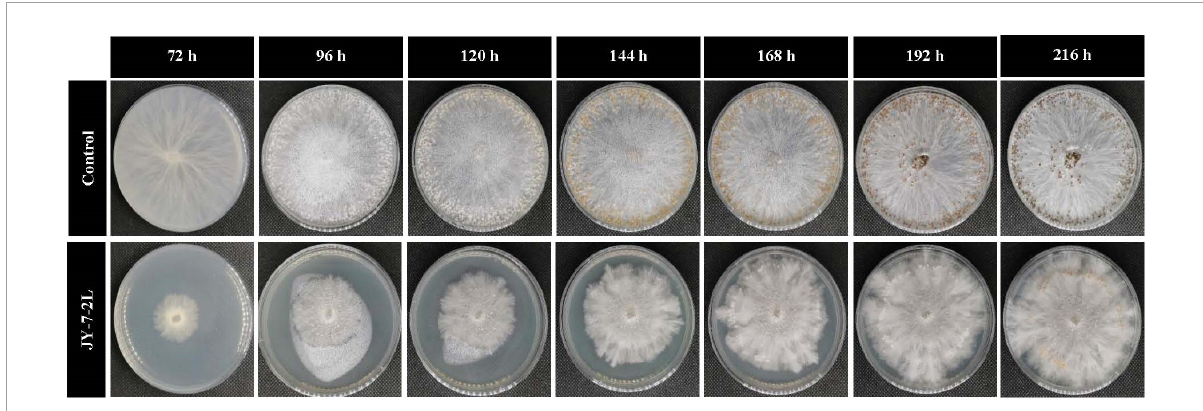
FIGURE3 Effect of cell-free culture filtrate of JY-7-2L on hyphal growth and sclerotia formation of Sclerotium rolfsii.